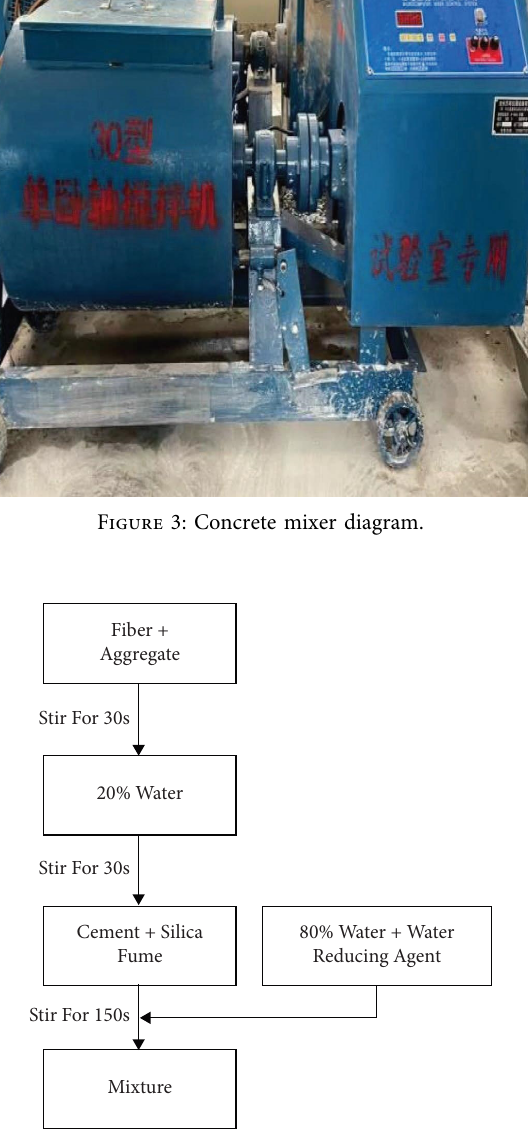
Figure 4: Flow chart of cement-wrapped stone method.